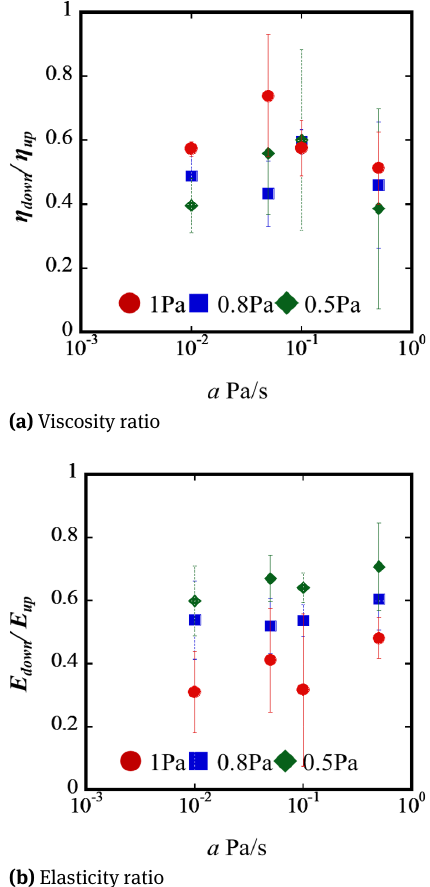
Figure 8: Shear-rate and stress dependences of viscosity and elas- ticity from single relaxation Maxwell model fitting (for τ max = 1 Pa). (a) Viscosity and (b) elasticity, for both the segments of increasing